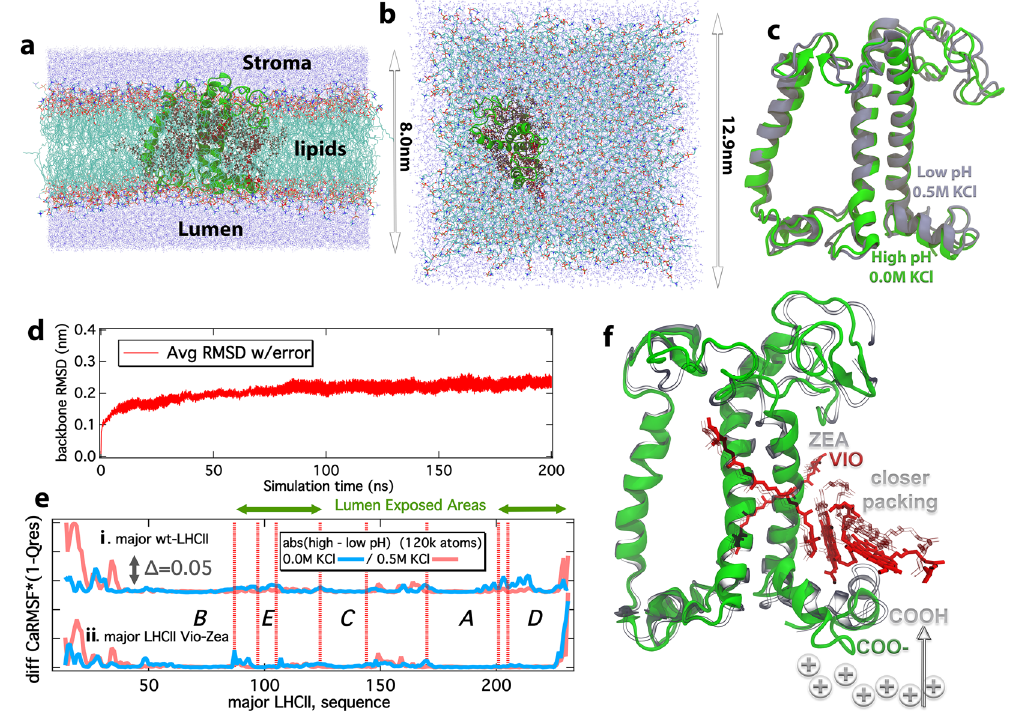
Figure 3. Simulations employing large membrane patches and a proposed model for the response of LHCs under NPQ conditions. ( a , b ) Side and Top views of the large membrane systems, with dimensions indicated. Water is shown in blue dots, lipid tails in light gray and lipid heads in red (oxygen) – blue (nitrogen). The protein matrix is shown in green cartoons, carotenoids in red and chlorophylls in dark gray. ( c ) Average structures out of the cluster averaging (400 ns per sample) for the high pH (0.0 M KCl) (green) and low pH (0.5 M KCl) (ice blue) states. ( d ) The average backbone Root mean Square Deviation (RMSD) in nm for all major LHCII (spinach) large membrane structures (400 ns cumulative sampling time per sample). ( e ) The product of Ca-RMSF * (1-Qres) in absolute high minus low pH difference in the presence (red) or in the absence (blue) of a Δ (KCl). The peaks indicate regions of high flexibility and distinct structural conformation for the major LHCII (spinach) in a large membrane patch and 400 ns cumulative sampling time per sample. ( f ) Schematic overview of the proposed response of the antenna complexes of Photosystem II, under NPQ conditions. Solid colors represent relaxing states (light harvesting), whereas transparent/gray colors represent a potential energy dissipating state (quenching), based on the major LHCII (spinach) response to Δ pH/ Δ (KCl). Different scaling has been used for the cartoons (green, helices-residues) and the pigments (red) for